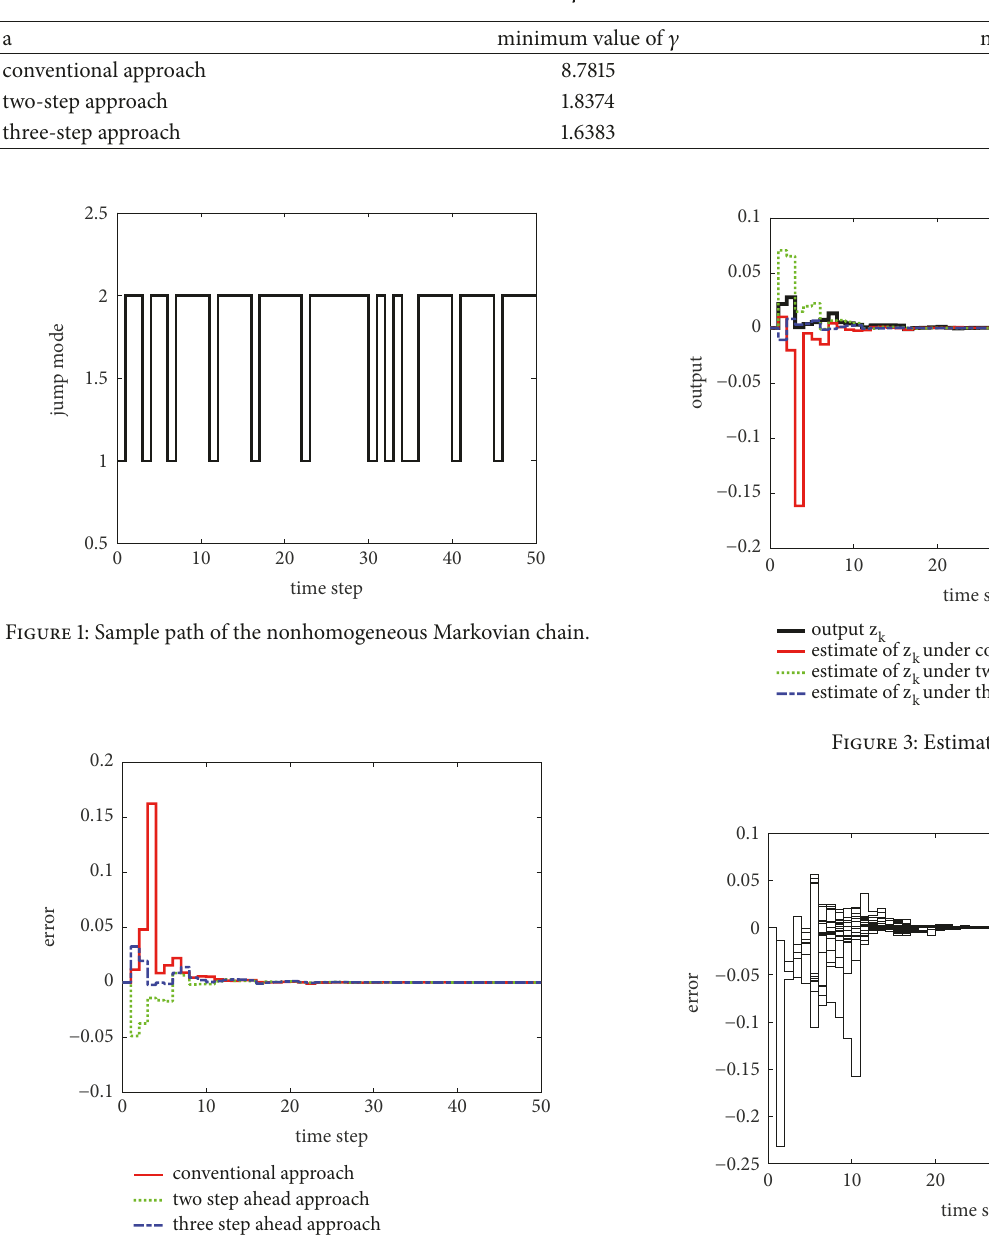
Table 1: Minimum value of 𝛾 and number of the decision variables.